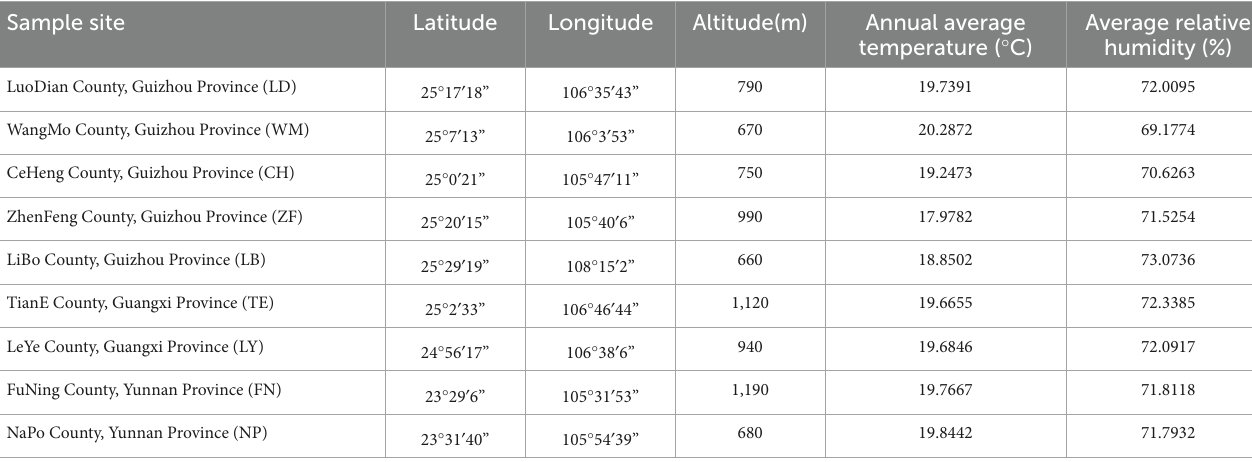
TABLE 1 Geographic and meteorologic information of each collection site. Sample